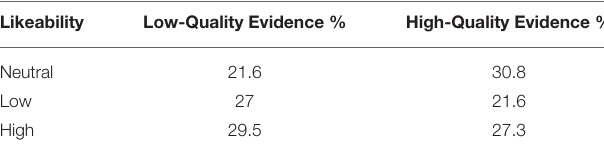
TABLE 9 | Proportion of participants selecting death sentence by evidence quality and likeability